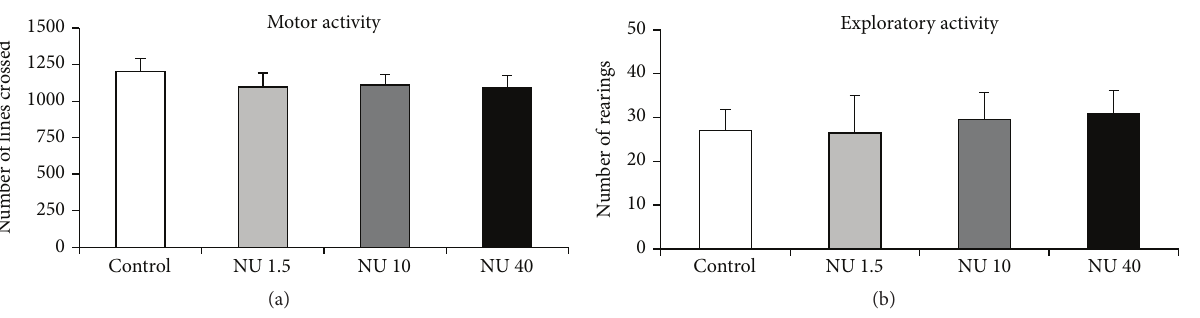
Figure 1: Total activity of male rats exposed to 1.5, 10, or 40mg ⋅ L −1 NU from birth for 9 months. (a) shows the number of lines crossed and reflecting locomotor activity. The number of rearings is presented in (b) and reflects exploratory activity. The data are presented as mean ± SEM; 𝑛 = 12 for each group; NU: natural